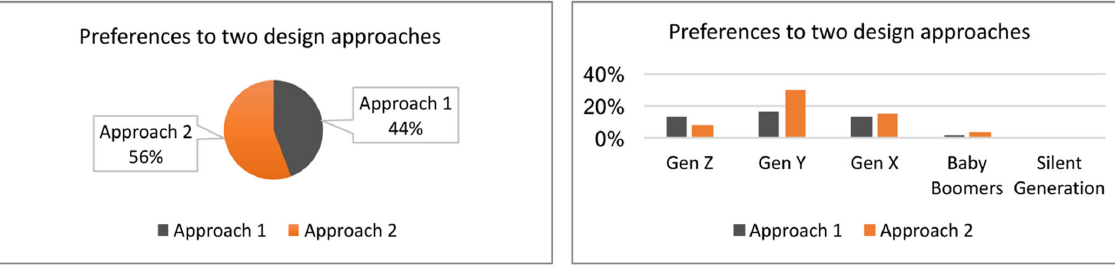
Figure 13. Percentage of respondents’ preferences for two design approaches.